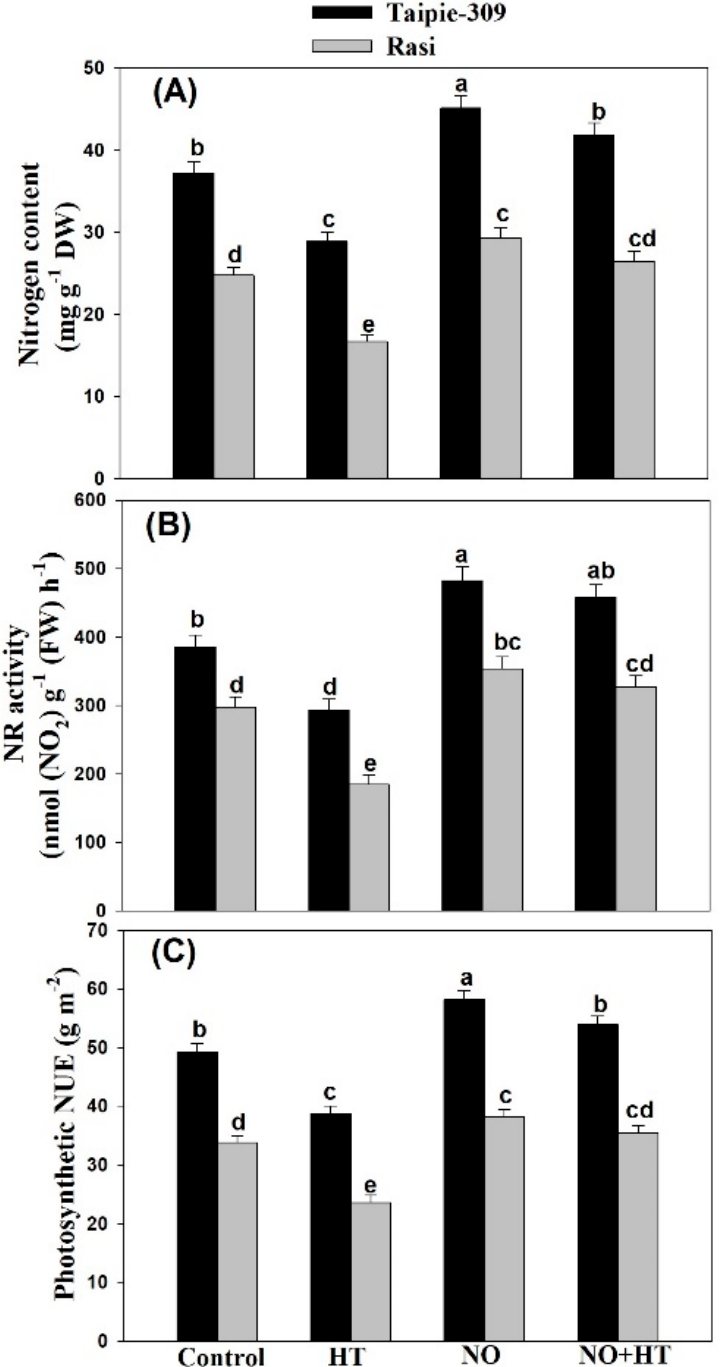
Figure 5. Leaf nitrogen content ( A ), NR activity ( B ), and photosynthetic NUE ( C ) in Taipie-309 and Rasi cultivars of rice ( Oryza sativa L.) at 30 days after germination (DAG), plants were grown with/without high temperature stress and treated with foliar 100 µ M SNP (NO donor). Data are presented as treatments mean ± SE (n = 4). The values followed by same letters above bars represent that data did not differ significantly by LSD test at p < 0.05. DW, dry weight; FW, fresh weight; NUE, nitrogen use efficiency.